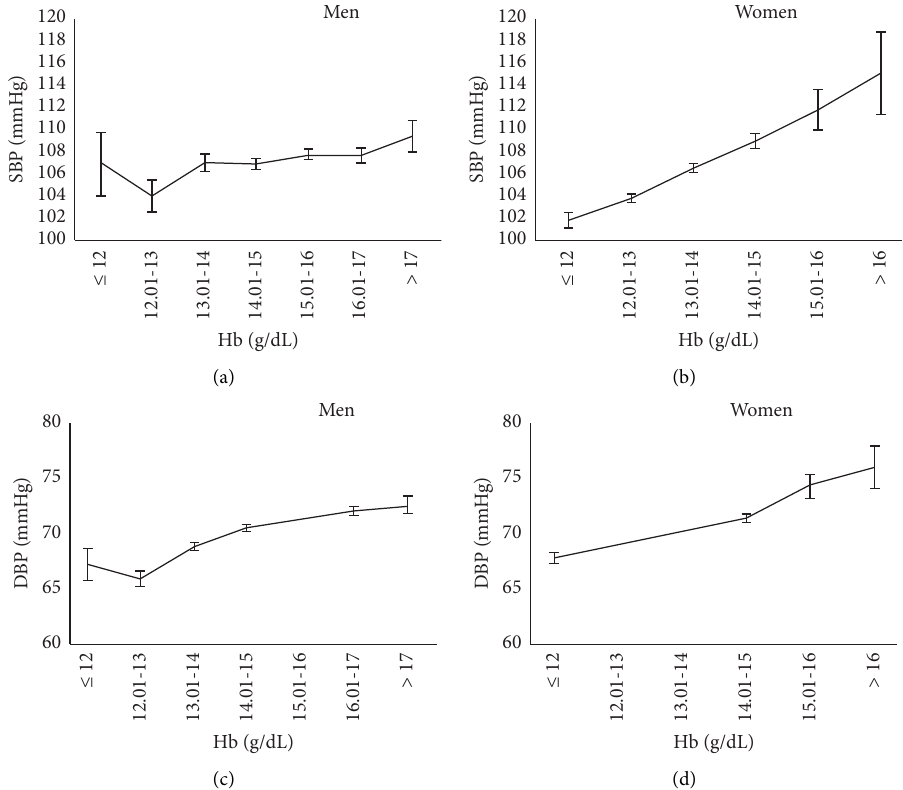
Figure 1: Trends of BP following the increase of hemoglobin concentrations at baseline (a) systolic BP in males, (b) systolic BP in females, (c) diastolic BP in males, and (d) diastolic BP in